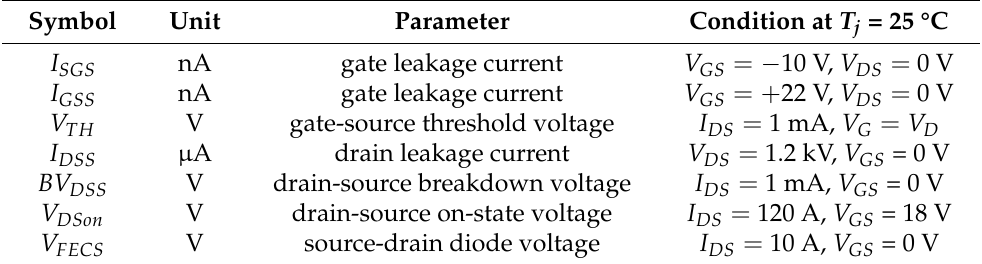
Table 2. Symbols and test conditions of some electrical parameters of the power